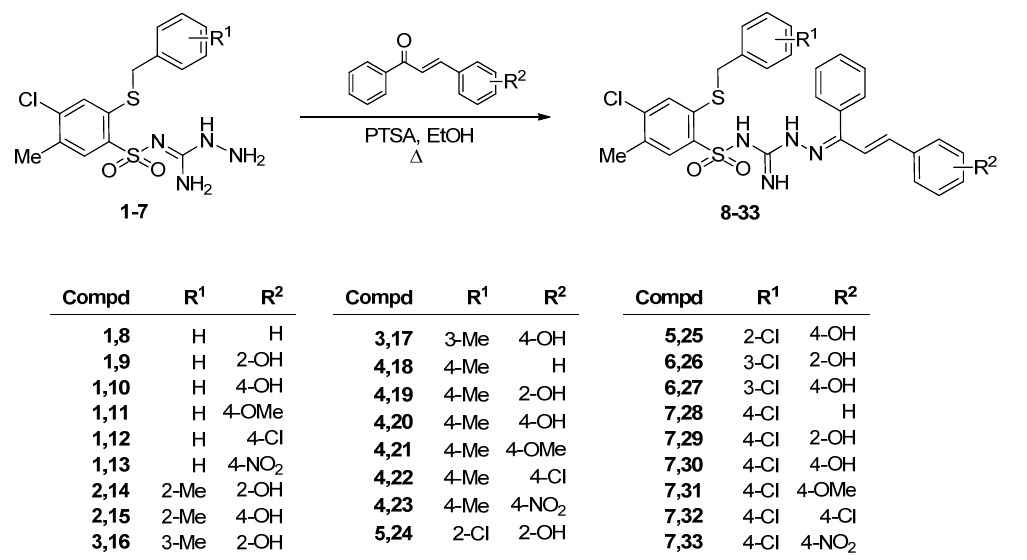
Scheme 1. Synthesis of new 3-(2-alkylthio-4-chloro-5-methylbenzenesulfonyl)-2-(1-phenyl-3- arylprop-2-enylideneamino)guanidine derivatives 8 – 33 ; PTSA—4-toluenesulfonic